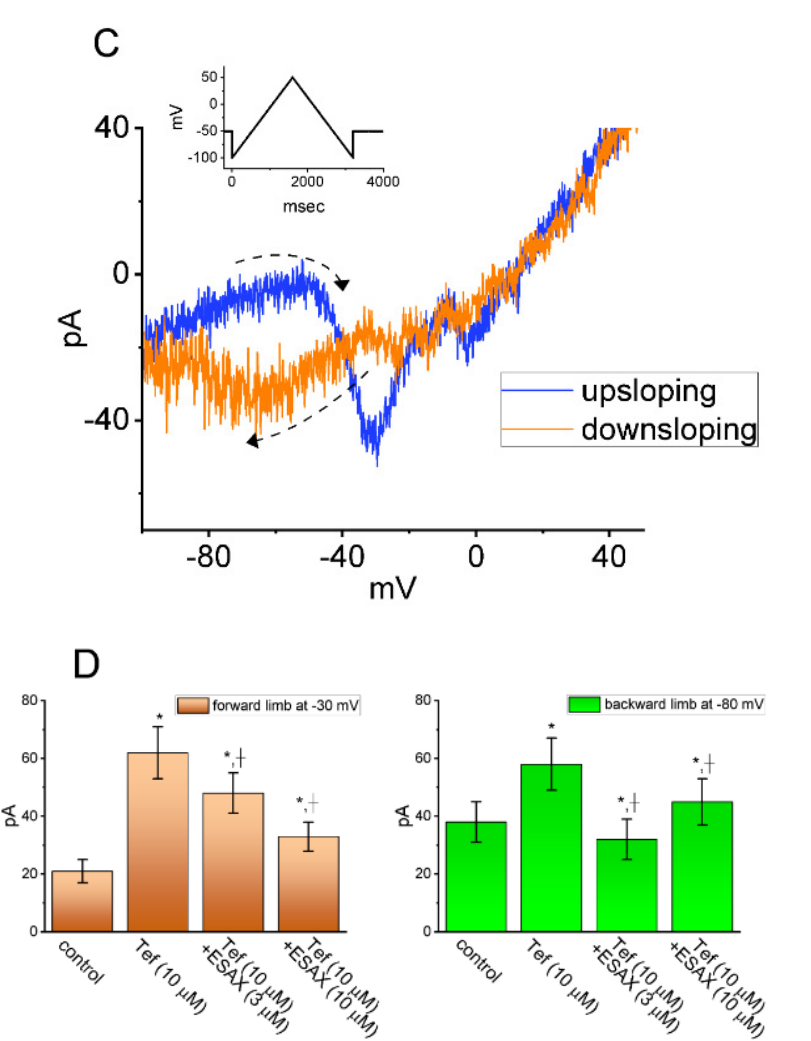
Figure 6. Inhibitory effect of ESAX on Tef-mediated increase in persistent I Na ( I Na(P) ) activated by isosceles-triangular ramp pulse in GH 3 cells. In these whole-cell current recordings, the potential applied to the examined cell was held at − 50 mV and the isosceles-triangular ramp voltage with varying durations of 0.4 to 3.2 s (i.e., ramp speed of ± 0.094 to 0.75 to mV/ms) to activate I Na(P) in response to the forward (from − 100 to +50 mV) and backward (from +50 to − 100 mV) ramp voltage-clamp command was delivered to it. ( A ) Representative current traces obtained in the control period (upper), and during cell exposure to Tef (10 µ M) (middle), or to Tef (10 µ M) plus ESAX (10 µ M) (lower). The black, red, or blue color indicated in the right upper side respectively denote the duration of isosceles-triangular ramp pulse applied (i.e., 0.8, 1.6 or 3.2 s, (i.e., the ramp speed of ± 0.38, ± 0.19 or ± 0.094 mV/ms)). Purple asterisks in the middle part of ( A ) shows Tef-induced augmentation in the amplitude of I Na(P) elicited by the upsloping and downsloping ends of the triangular ramp. ( B ) Representative instantaneous I–V relation of I Na(P) in response to isosceles-triangular ramp pulse with a duration of 0.8 s (black color) or 3.2 s (blue color). The current traces in the up- per part are controls, while those in the middle or lower part were respectively acquired from the presence of Tef (10 μ M) alone or Tef (10 μ M) plus ESAX (10 μ M). The dashed orange arrows in the middle part and the right side of ( B ) show the direction of I Na(P) trajectories in which time passes during the elicitation by the upright isosceles-triangular ramp pulse with a duration of 0.8 s (black color) or 3.2 s (blue color). The graph in the right side shows an expanded record of the dashed box in the left middle part. The asterisks in the middle part of ( B ) indicate the figure-of-eight (or infinity-shaped: ∞ ) loop (as demonstrated in the right side) of voltage-dependent hysteresis re- sponding to the triangular ramp. ( C ) Figure-of-eight pattern in voltage-dependent hysteresis of I Na(P) activated by isosceles-triangular ramp voltage with a ramp duration of 3.2 s (or a ramp speed